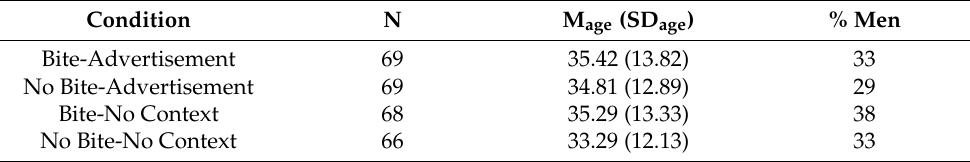
Table A2. Demographics of the different conditions in Study